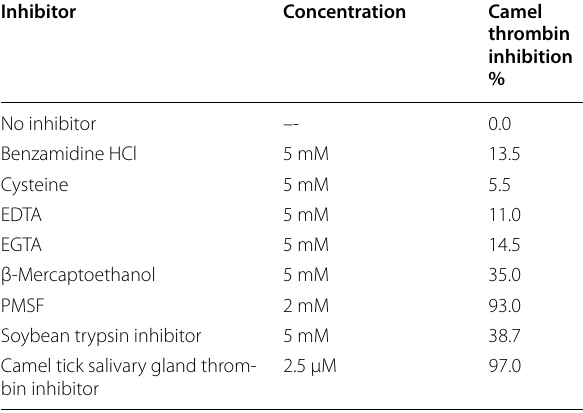
Table 2 Effect of different inhibitors on the purified